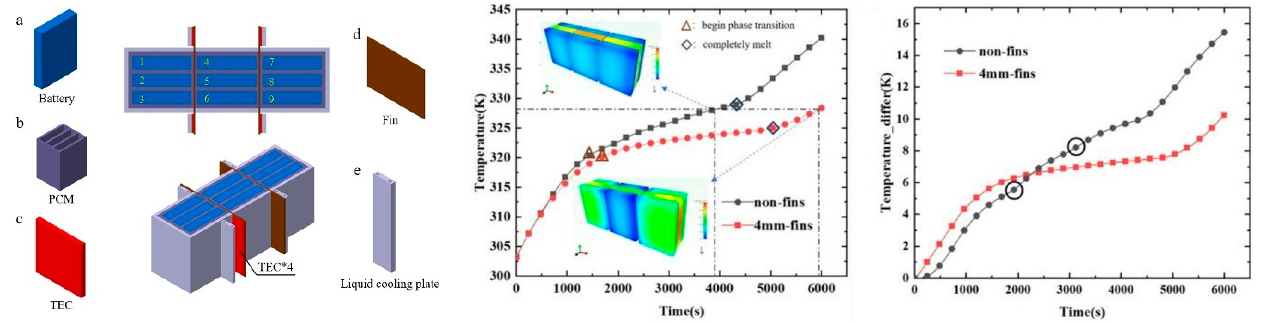
Figure 31. ( Left ): The hybrid BTMS with fins, TEC and PCM: ( a ) the battery cell; ( b ) the PCM; ( c ) thermoelectric cooler; ( d ) metallic fin; ( e ) liquid cooling plate; Middle: The battery temperature (no fins versus 4 mm fins); ( Right ): The temperature difference. Reproduced from [106] with permission from